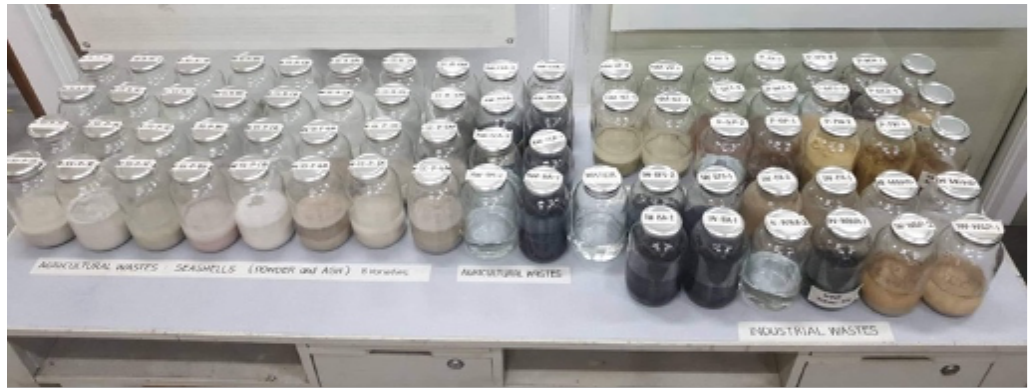
Figure 3. Candidate materials for DO testing.